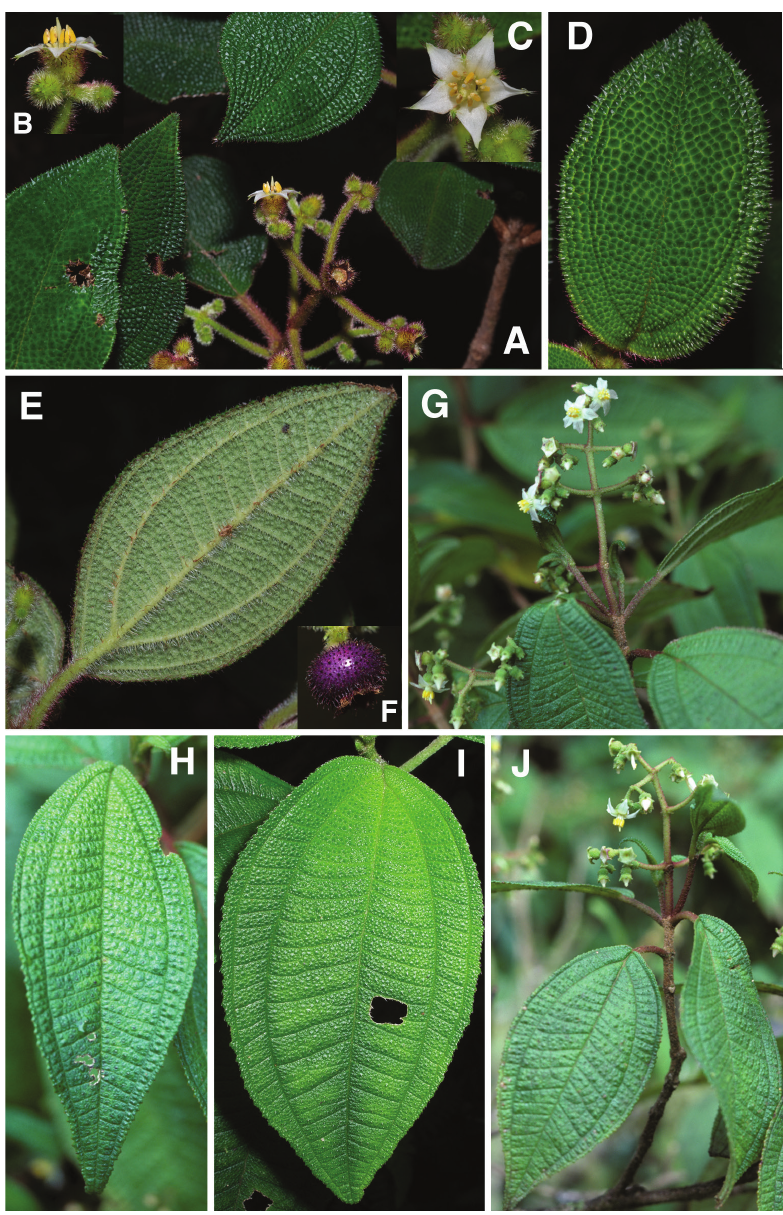
Figure 15. Photos of M. argentimuricata ( A–F ) and M. asperifolia ( G–J ). A Inflorescence of M. ar- gentimuricata B side view of flower showing long, slightly bulla-based hairs on the petal abaxial surface C flower frontal view D leaf adaxial surface showing striking bulla-based hairs E leaf abaxial surface showing pitting F mature fruit (all from Michelangeli 2219 ) G inflorescence and flower frontal view of M. asperifolia ( Judd 5357 ) H leaf adaxial surface showing well-developed bulla-based hairs ( Judd 5357 ) I leaf adaxial surface showing poorly developed bulla-based hairs ( Ionta 2005 ) J habit and inflorescence of M. asperifolia ( Judd 5357 ). Photos A–F taken by F. Michelangeli and G–J by W.S.